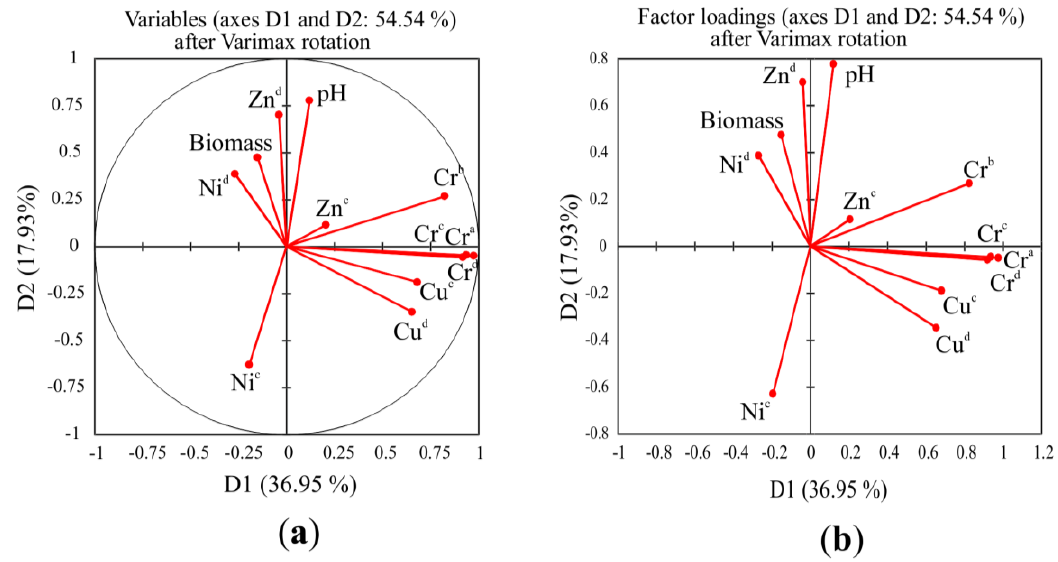
Figure 9. Plot of scores of principal component. ( a ) Variable after varimax rotation. ( b ) Factor loading after varimax rotation. a metal concentrations in the above-ground plant material. b metal concentrations in the root; c total content in soil; d CaCl 2 -extractable metal concentration.